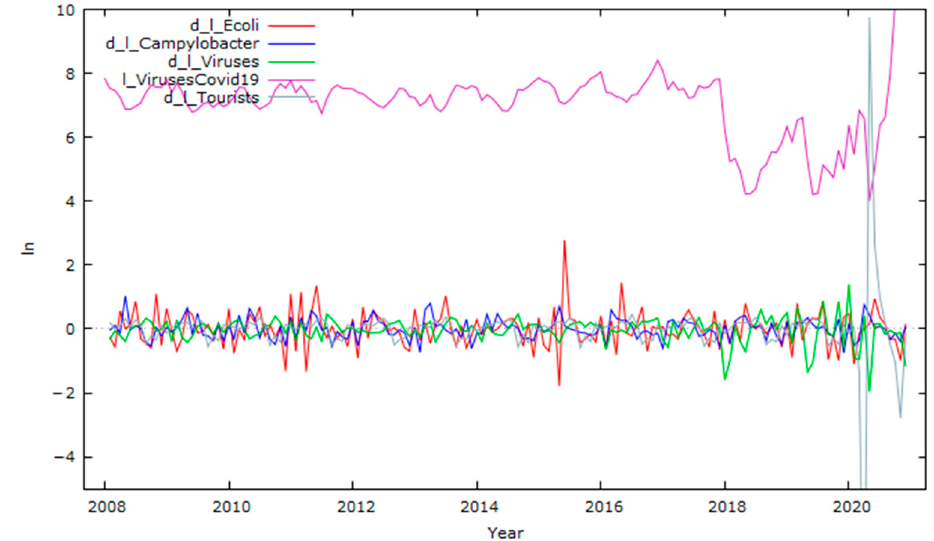
Figure 4. Differenced variables. Sources: authors compilation based on Table 2.